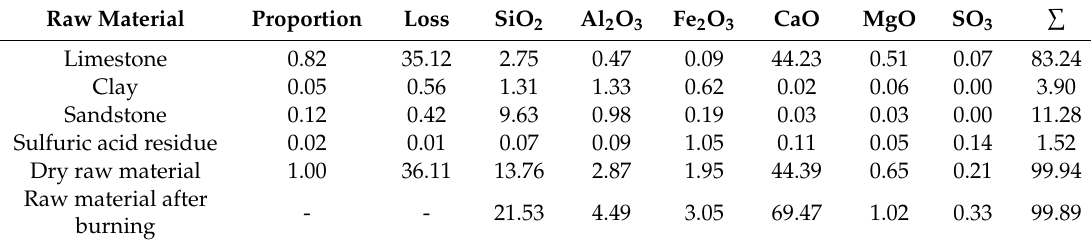
Table 6. Raw material ratio calculation (unit: 100 kg).